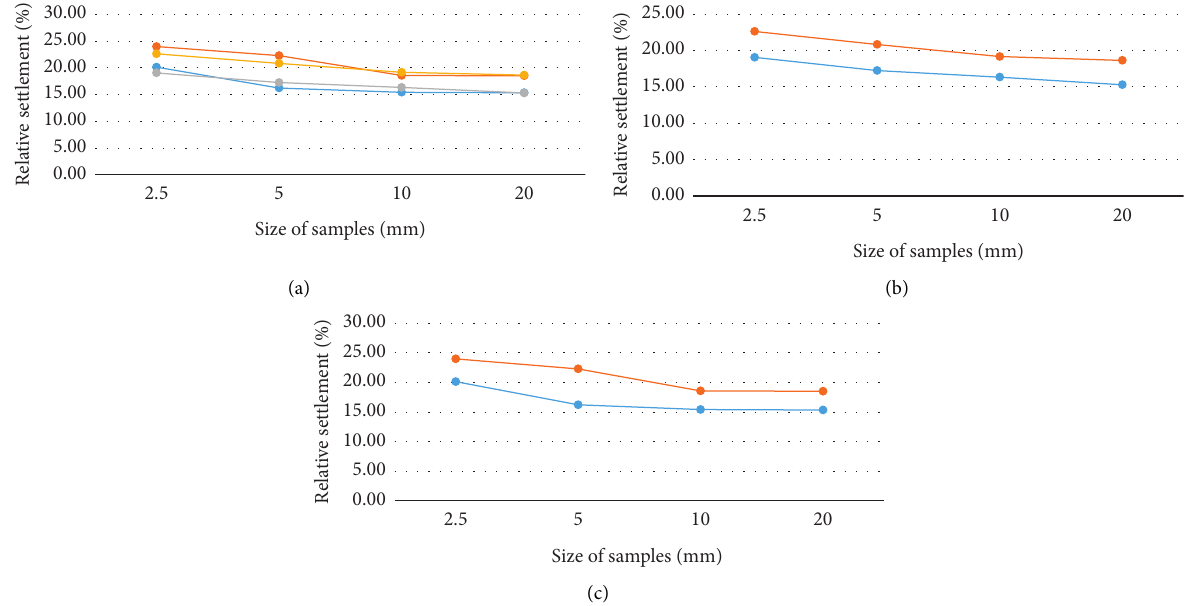
Figure 10: Relative settlement of uniform granulation materials by funnel and spoon precipitation method, sudden precipitation, and comparative precipitation.